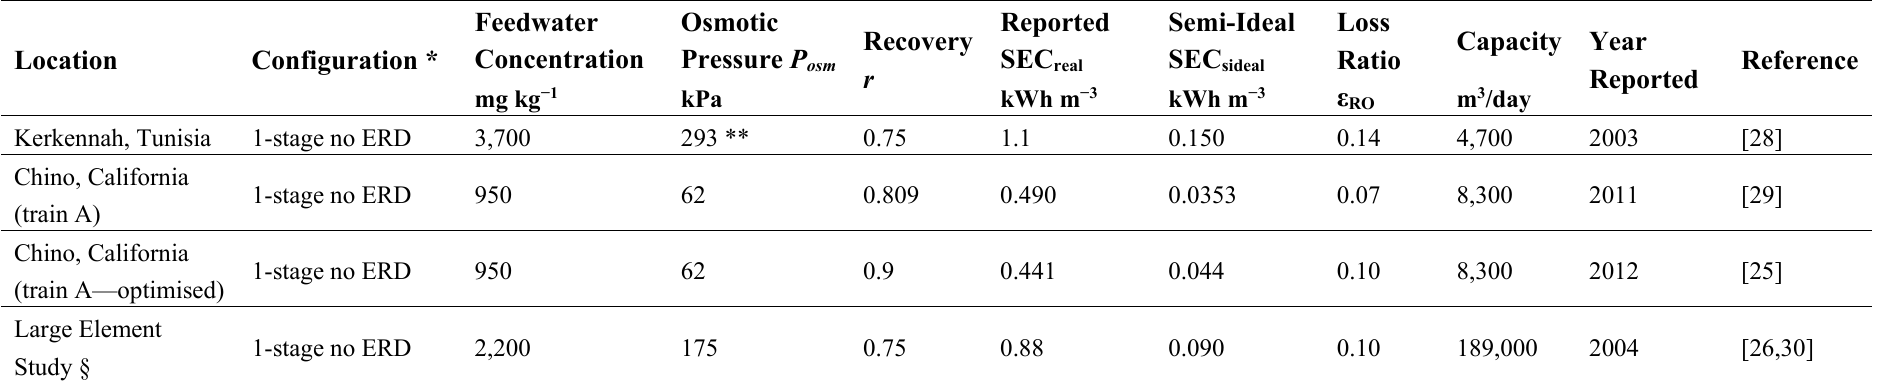
Table 2. Comparison of theoretical and real specific energy consumptions of some reported brackish water RO systems.